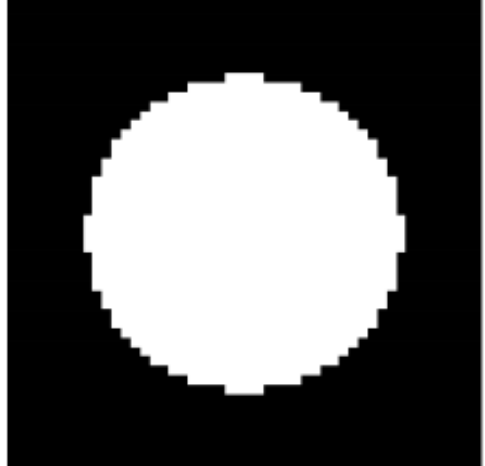
Figure 2. Initial unit